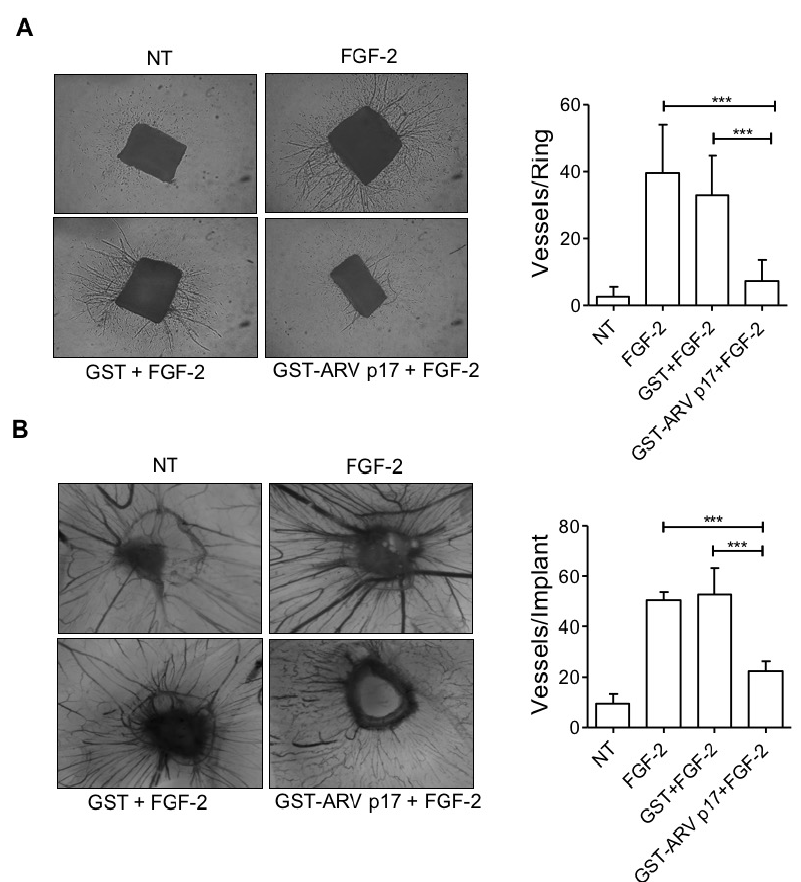
Figure 5. In vivo and ex vivo effects of ARV p17 on angiogenic process. ( A ) Mouse aortic rings, embedded in fibrin gel, were incubated for 24 h, as indicated. After 6 days, micro-vessels were observed, counted under a stereomicroscope and data were expressed as the number of sprouts per aortic ring (mean ± SD of 7–10 rings per experimental point). Pictures are representative of two independent experiments with similar results (original magnification, 4×). Statistical analysis was performed by one-way analysis of variance (ANOVA) and Bonferroni’s post-test was used to compare data. *** p < 0.001. ( B ) Micro-vessels converging towards the implant were counted at day 14 under a stereomicroscope. Pictures of CAMs are representative of two independent experiments with similar results (original magnification, 5×). Bars represent the mean ± SD of 4–5 eggs per experimental point in two independent experiments. Statistical analysis was performed by one-way ANOVA and Bonferroni’s post-test was used to compare data. *** p < 0.001.